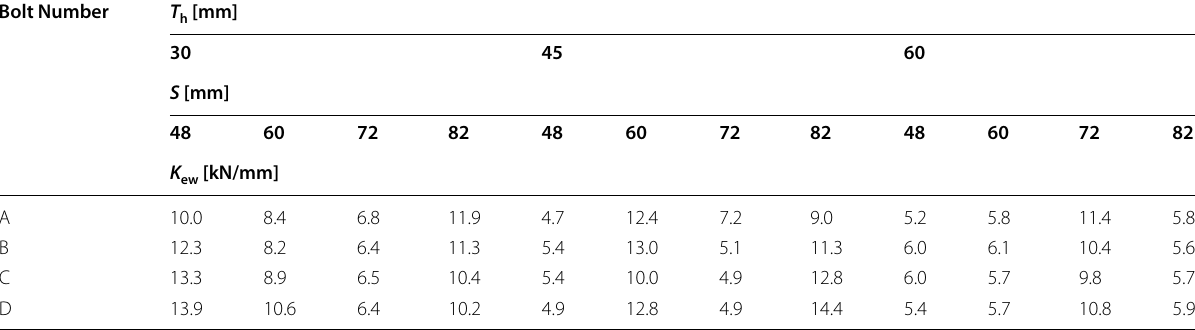
Table 5 Results for embedment stiffness of a metal washer into a timber member Bolt Number